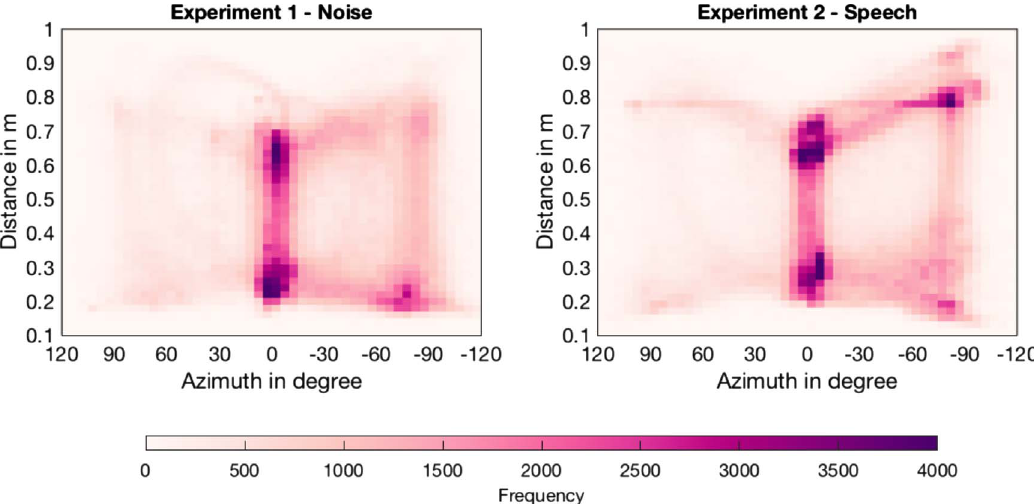
Figure 3. Two-dimensional histograms of the relative tracking data of Experiment 1 (left) and Experiment 2 (right), pooled over all participants and trials in the respective experiment.